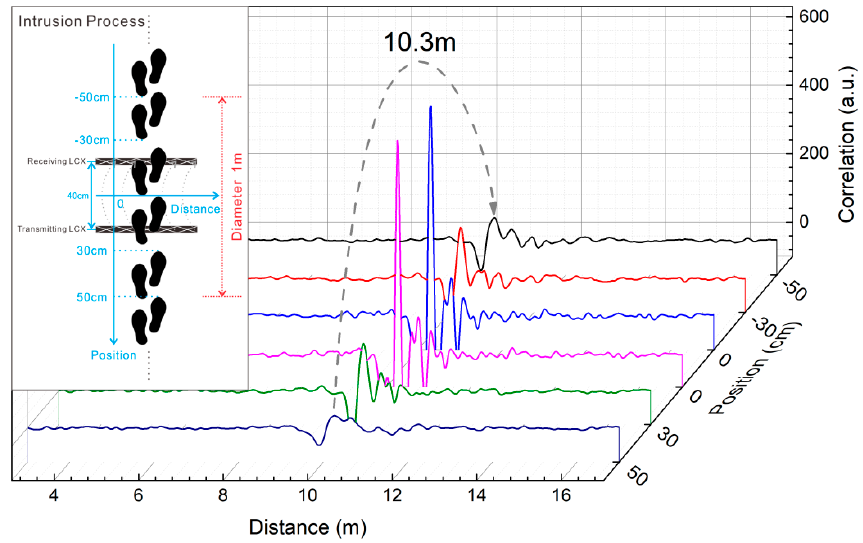
Figure 6. Detection results of intrusion process.